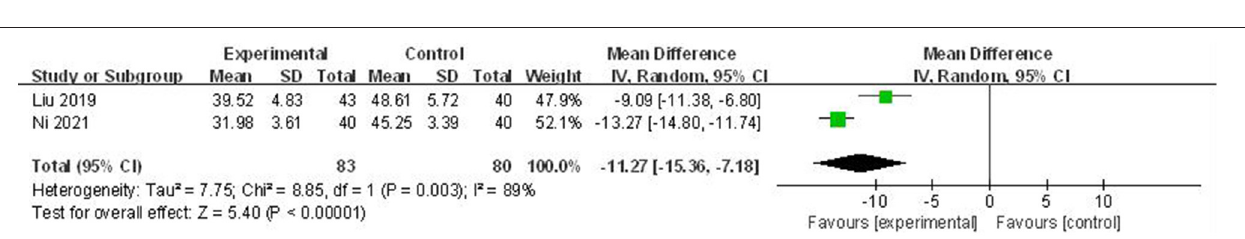
FIGURE 6 | Forest plots of acupuncture plus standard treatment vs. standard treatment: analgesic onset time.